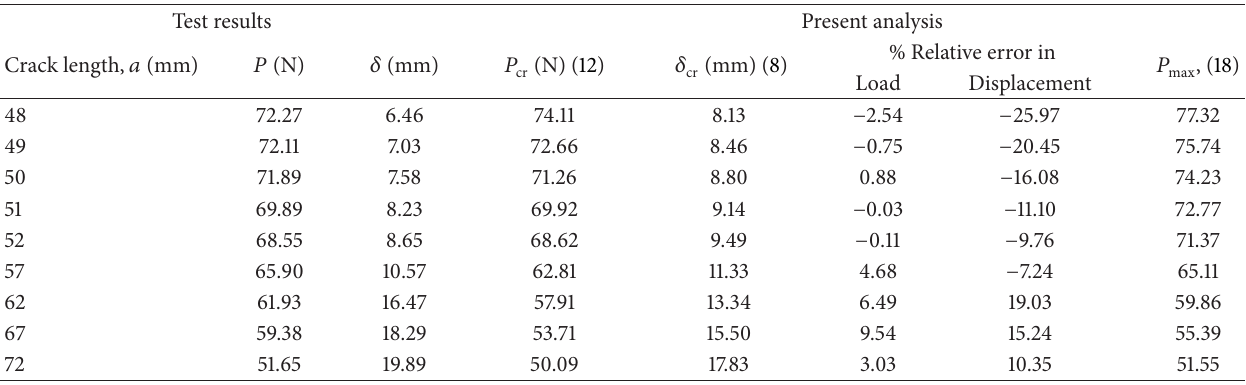
Table 3: Critical load, 𝑃 , and corresponding displacement, 𝛿 cr glass/epoxy